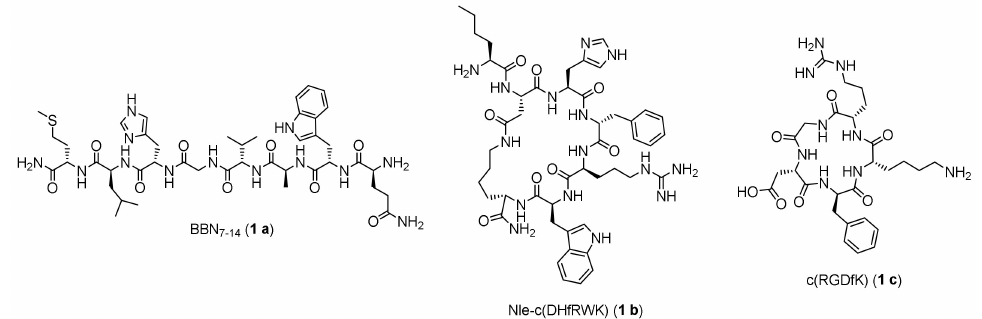
Figure 2. Structures of the peptides BBN 7-14 ( 1 a ), Nle-c(DHfRWK) ( 1 b ) and c(RGDfK) ( 1 c ), specifically binding to the GRPR, MC1R and integrin α v β 3 which were chosen as receptor-specific carriers for the preparation of the hybrid, dually labelled tumor targeting